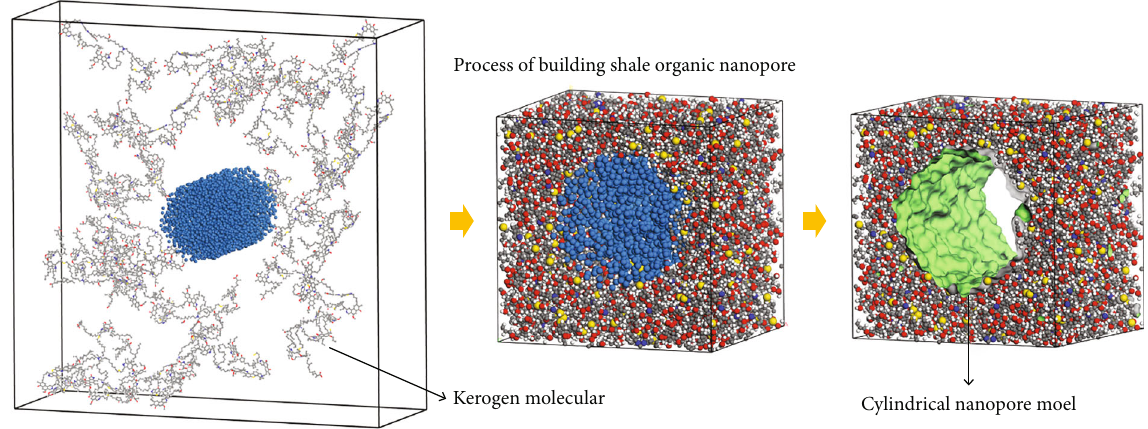
Figure 1: The kerogen molecular model of di ff erent types. (a) The type-I kerogen C C H O N S ; (c) the type-III kerogen C 252 294 24 6 3 and yellow for S.